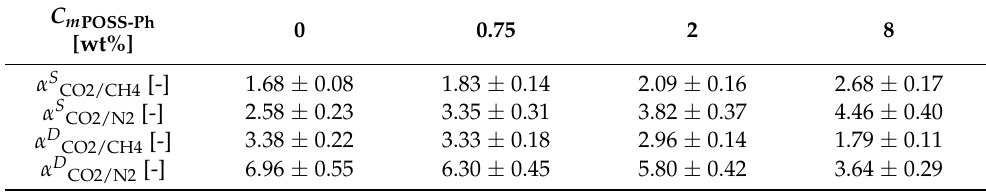
Table A12. Coefficients α S i/j and α D i/j for membranes of different POSS-Ph